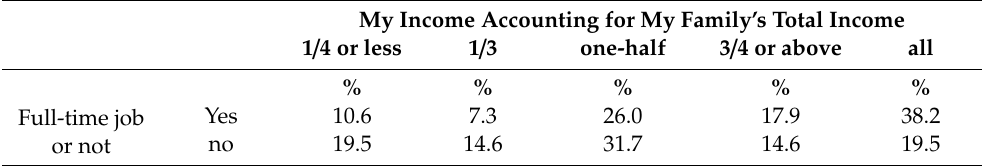
Table A5. Relationship between type of employment and income contribution to total household income (percentage).